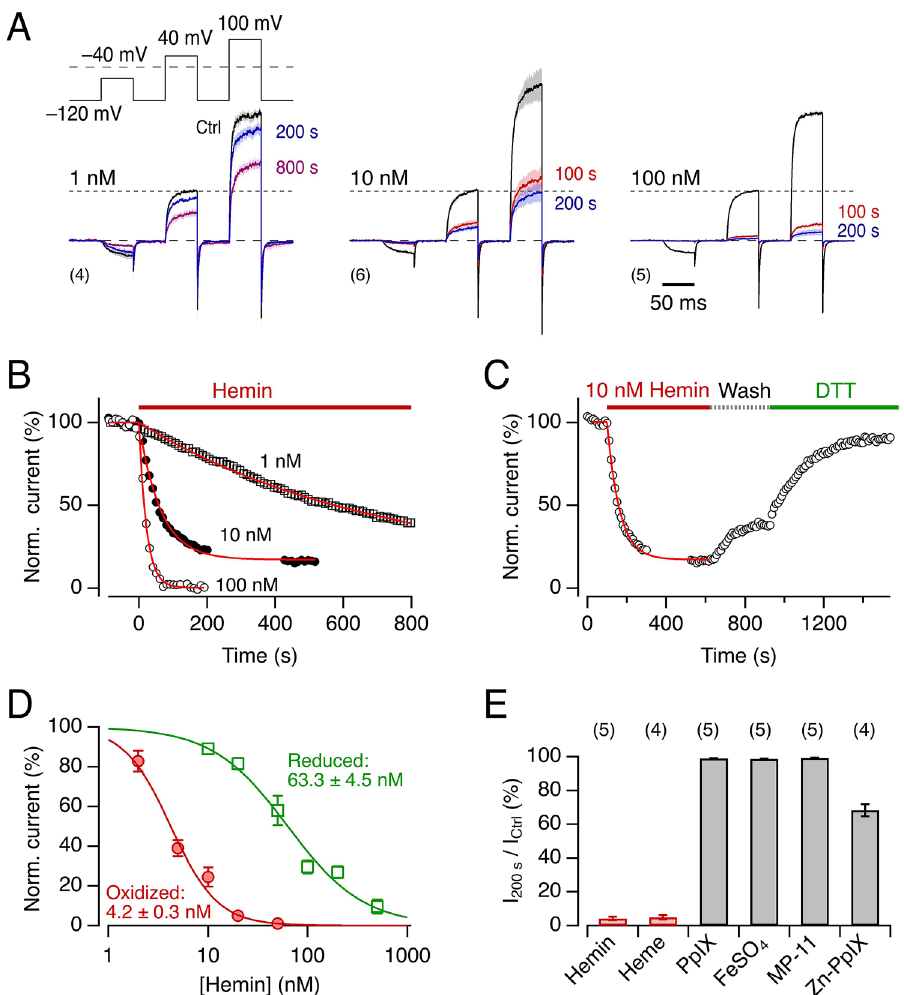
Figure 1. Kv10.1 current inhibition by hemin. ( A ) Mean traces of Kv10.1 channel currents from Xenopus oocyte inside-out patches, stimulated with the indicated pulse protocol, before (black) and recorded at the indicated times (color) after hemin application at 1 nM (left), 10 nM (center), or 100 nM (right). Traces are normalized to the maximal current at 40 mV obtained under control conditions. Thick traces are means, sem is indicated in shading, the number of recordings n in parentheses. ( B ) Time course of normalized maximal currents at 40 mV with application of hemin at the indicated concentration at time zero. The superimposed curves are the results of single-exponential fits. ( C ) As in ( B ) with 10 nM hemin application, wash with control solutions (Wash), and final exposure of the inside-out patch to a control solution with 1 mM DTT. The solid line is a single-exponential data fit to characterize the onset of current inhibition. ( D ) Steady-state Kv10.1 current inhibition at 40 mV, recorded from inside-out Xenopus oocyte membrane patches, as a function of hemin concentration in oxidizing (no GSH, red circles) and reducing (with 1 mM reduced GSH, green squares) conditions. The continuous curves are the result of Hill fits (Eq. 3) yielding the indicated half-maximal inhibition concentrations. ( E ) Mean remaining current at 40 mV in Kv10.1-containing inside-out patches after 200-s application of hemin (Fe 3+ ), heme (Fe 2+ ), protoporphyrin IX (PpIX), and Zn(II) protoporphyrin IX (Zn-PpIX) (all at 50 nM concentration), as well as FeSO 4 (1 µM) and MP-11 (1 µM). Data are mean ± sem, n in parentheses. For current traces, see Supplementary Fig. S1. Solutions: Standard